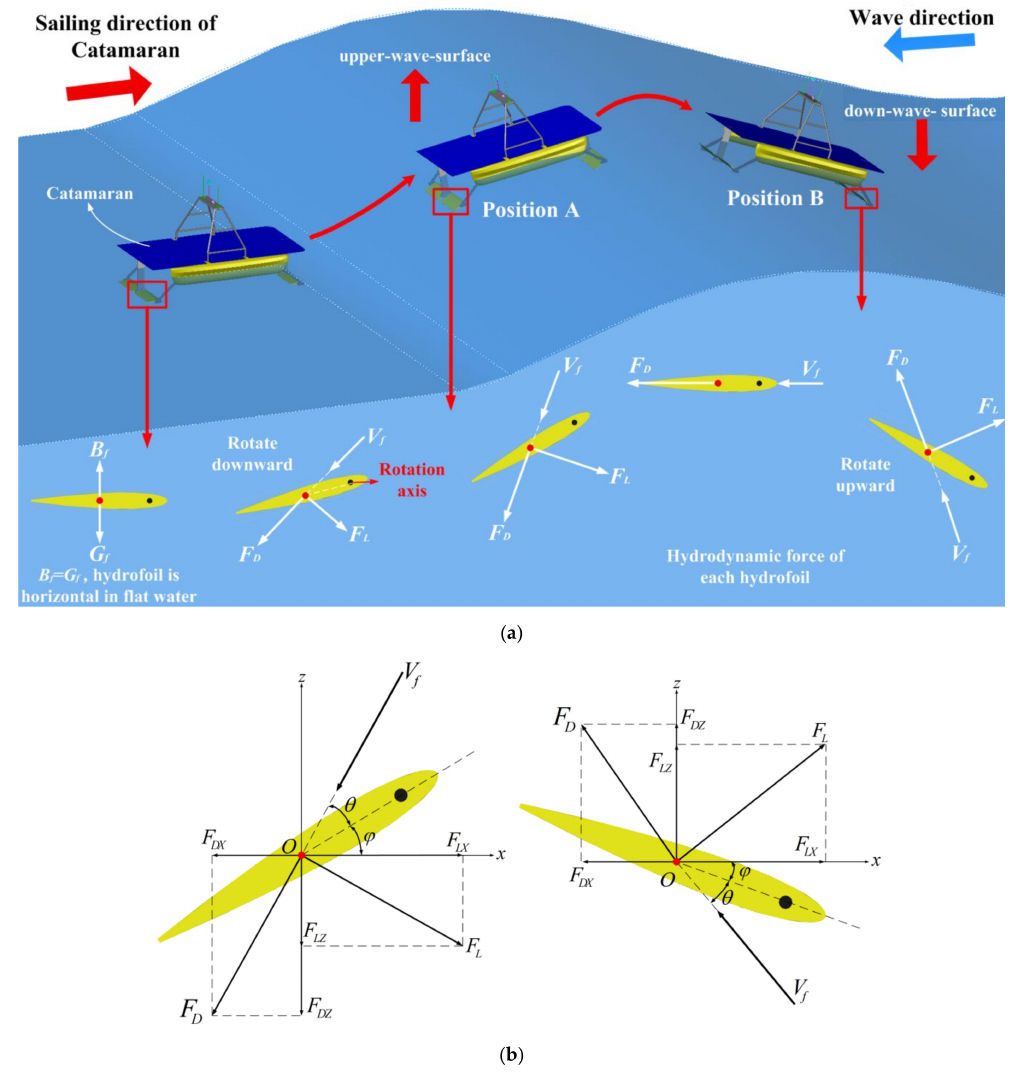
Figure 3. Schematic diagram of self-propulsion process of wave-driven catamaran and force analysis of each hydrofoil. ( a ) Self-propulsion process of wave-driven catamaran. ( b ) Force analysis of each